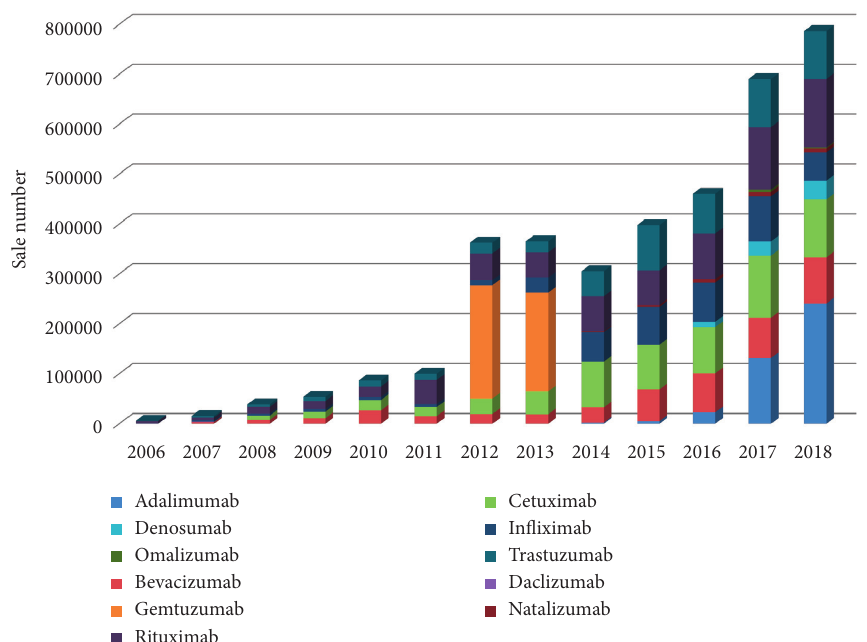
Figure 3: Frequency of MTAs used in Iran from 2006 to 2018.